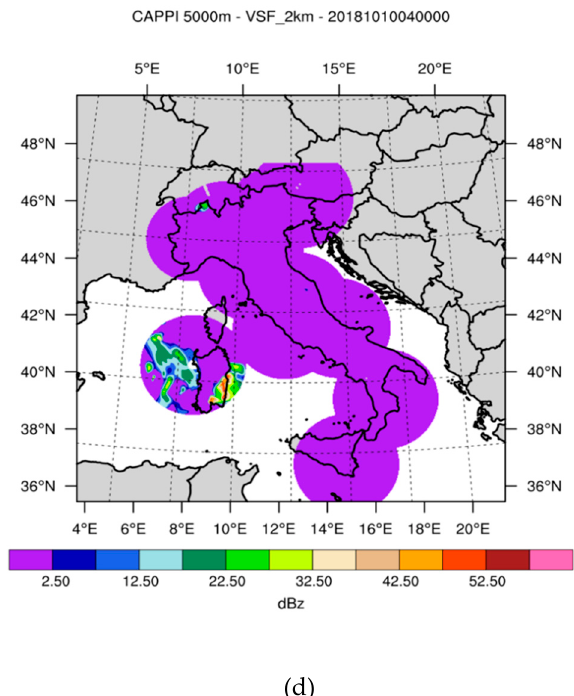
Figure 8. CAPPI simulated at 04 UTC and at 5 km by ( a ) CTRL; ( b ) VSF_3h; ( c ) VSF_1h; ( d ) VSF_2km. Table 3. Scores of simulated reflectivity for three different reflectivity thresholds (0, 5, and 15 dBz) and for three observation levels (2000, 3000, and 5000 m). Scores are computed for the four VSF configurations considered in the paper (CTRL, VSF_3h, VFS_1 h, VSF_2km). FBIAS is the frequency bias, ETS is the equitable threat score, POD is the probability of detection, and FAR is the false alarm rate.